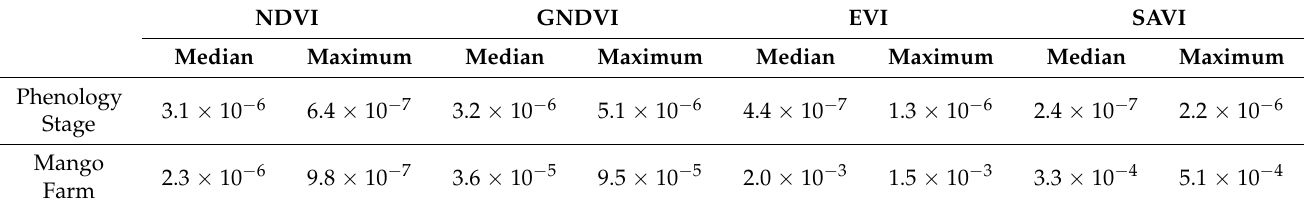
Table 4. Results of two-factor ANOVA analysis between the farms